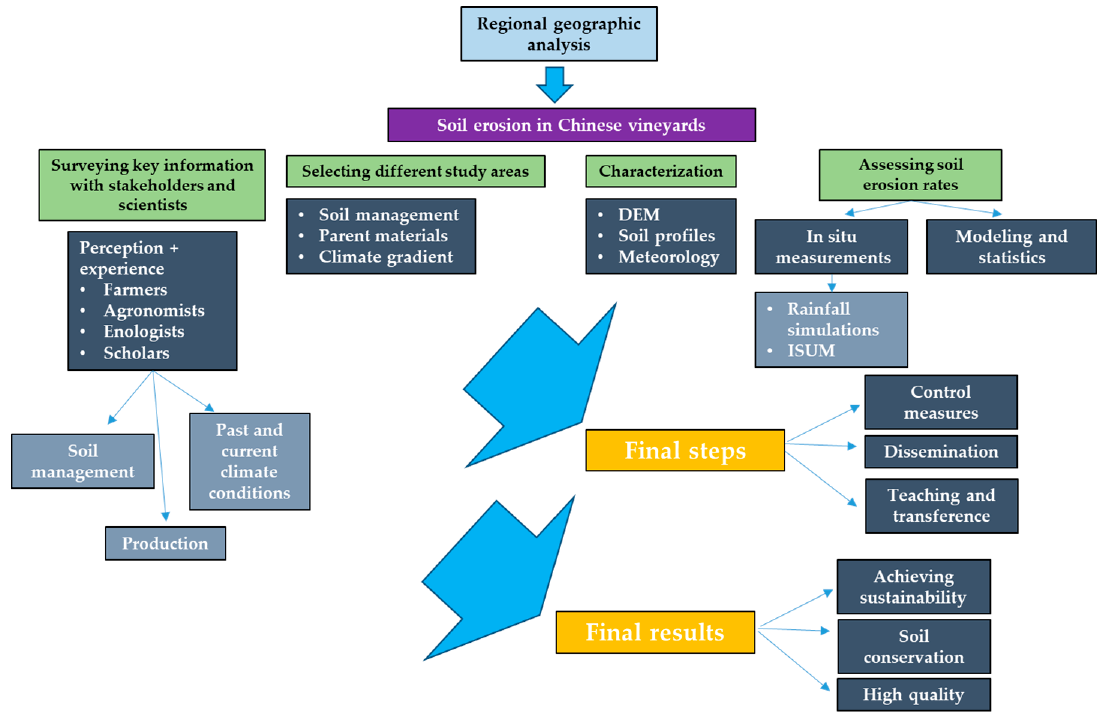
Figure 4. A flowchart showing the potential steps or working packages to design a research plan to investigate soil erosion in Chinese vineyards. *DEM: Digital Elevation Model; ISUM: Improved Stock Unearthing Method.